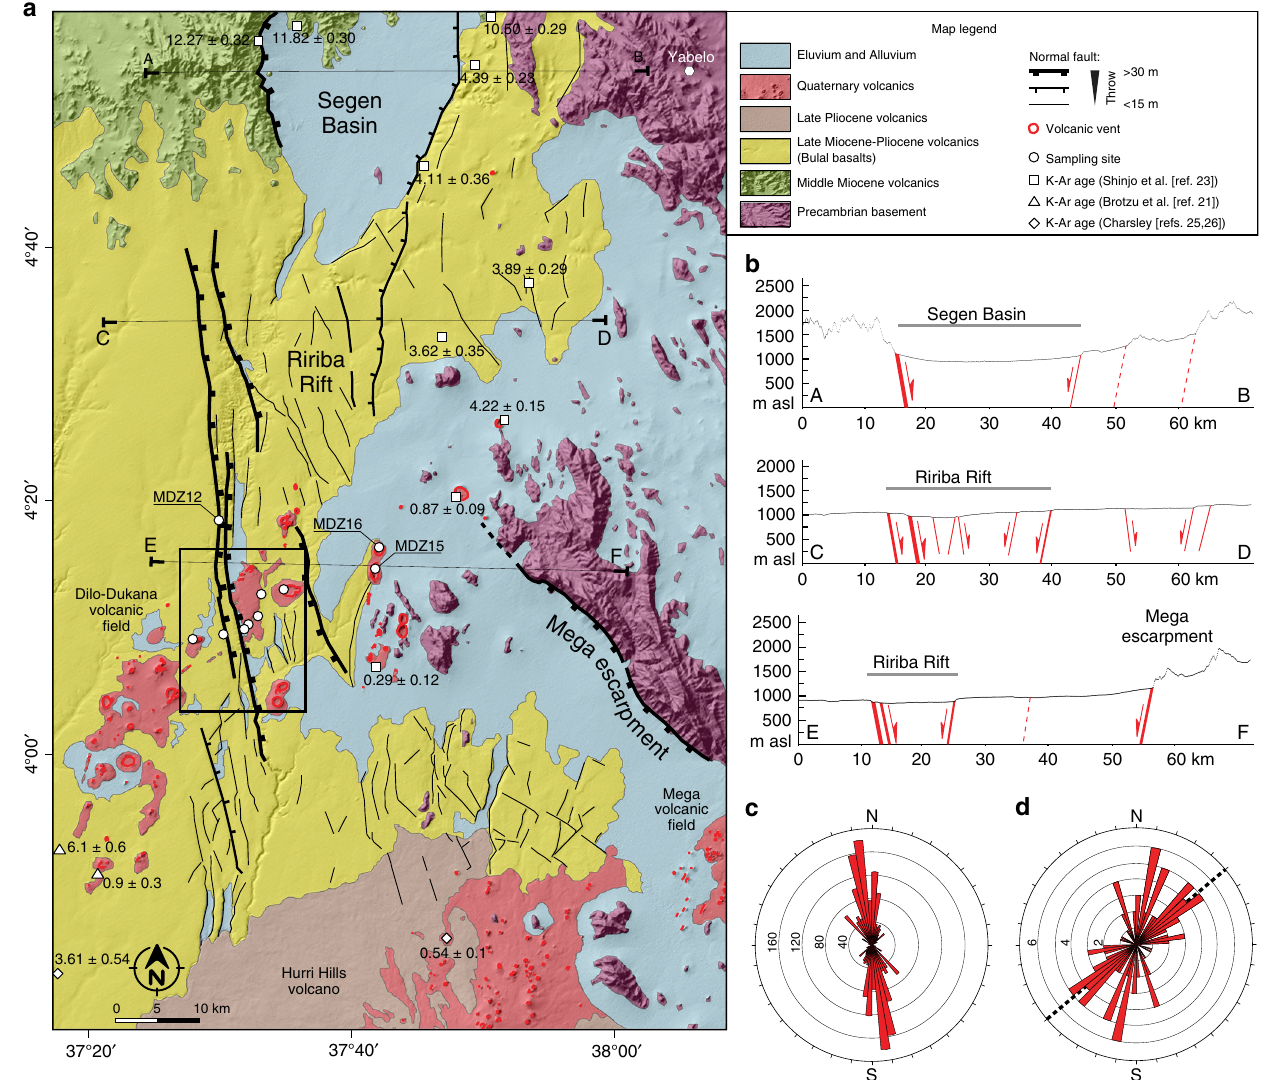
Fig. 2 Geology of the Ririba rift. a Geological map superimposed on a SRTM (Nasa Shuttle Radar Topography Mission) digital elevation model. White dots labelled ‘ MDZ + number ’ indicate rock samples. Black square indicates the area illustrated in Fig. 3. b Simpli fi ed structural cross-sections across the Segen Basin (A-B) and the Ririba rift (C-D, E-F). c Rose diagram illustrating plots of weighted fault azimuths. The weighting factor for each fault is the ratio between the length and the minimum length of the whole data set, such that long faults have higher ratio (weight) than short ones. The frequency of the azimuth of a fault directly relates to this ratio, the longer the fault the higher its frequency. d Rose diagram illustrating plots of the elongation of volcanic vents; the dashed black line indicates the overall elongation of the Dilo-Dukana volcanic fi